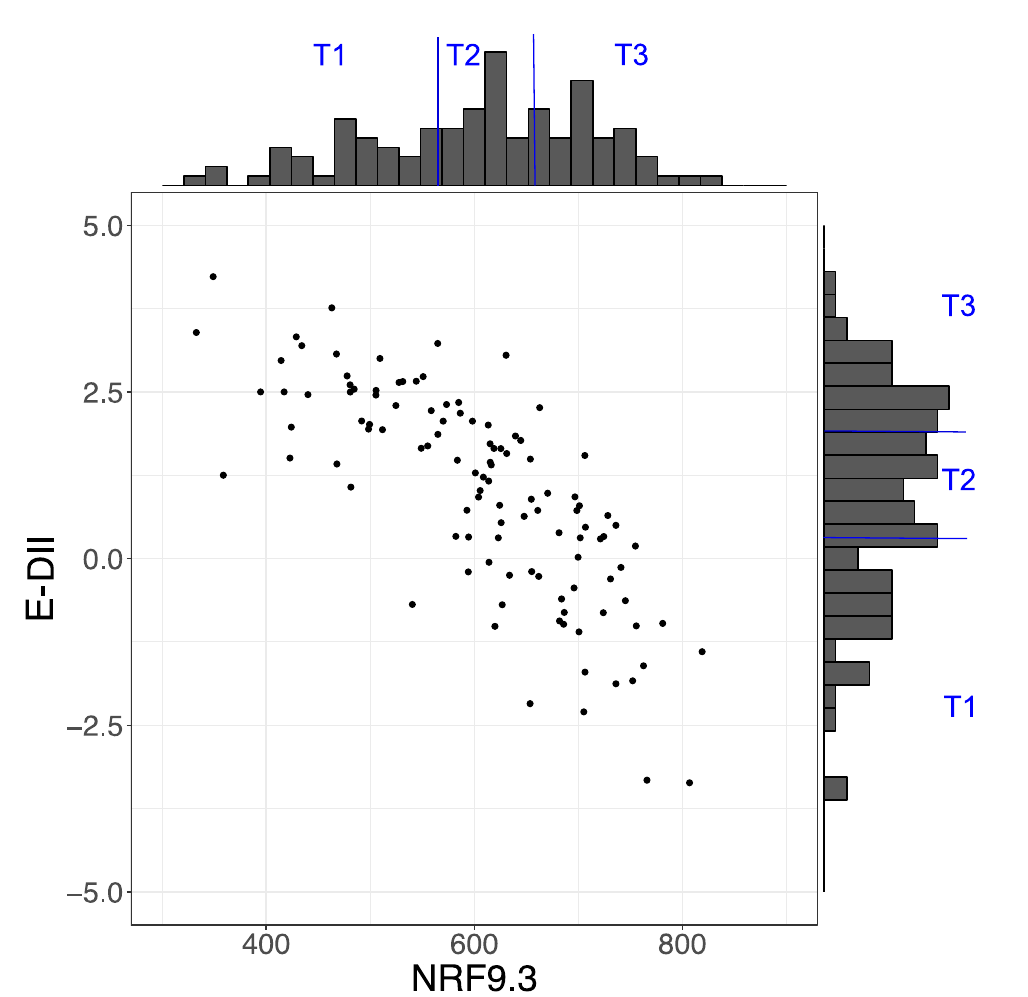
Figure 2. Distribution of Nutrient-Rich Food Index 9.3 (NRF9.3) and energy-adjusted dietary inflammatory index (E-DII) scores. Scatter plot showing the relationship between NRF9.3 and E-DII scores.